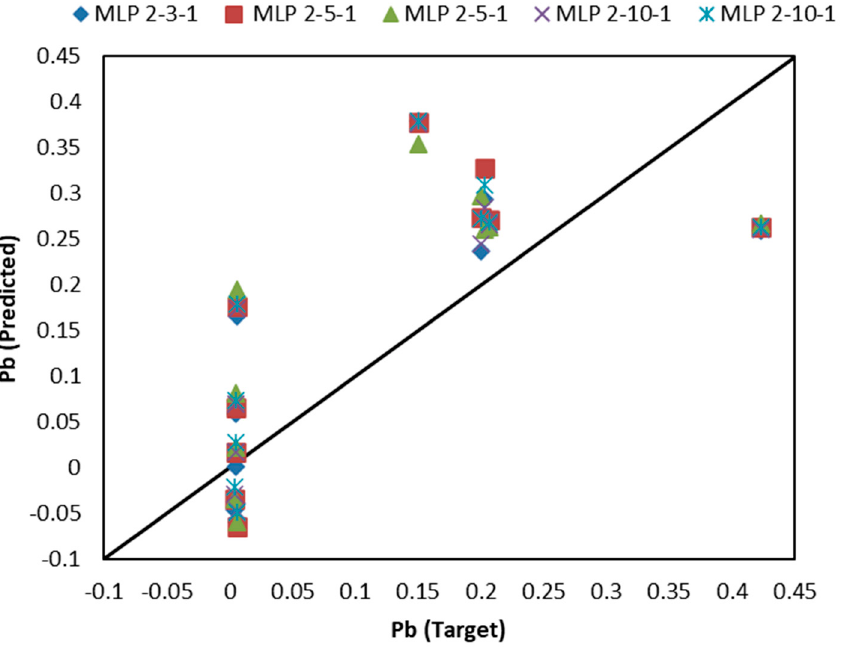
Table 4. Correlation coefficients and RMSE values for different MLP topologies in all stages for Pb .